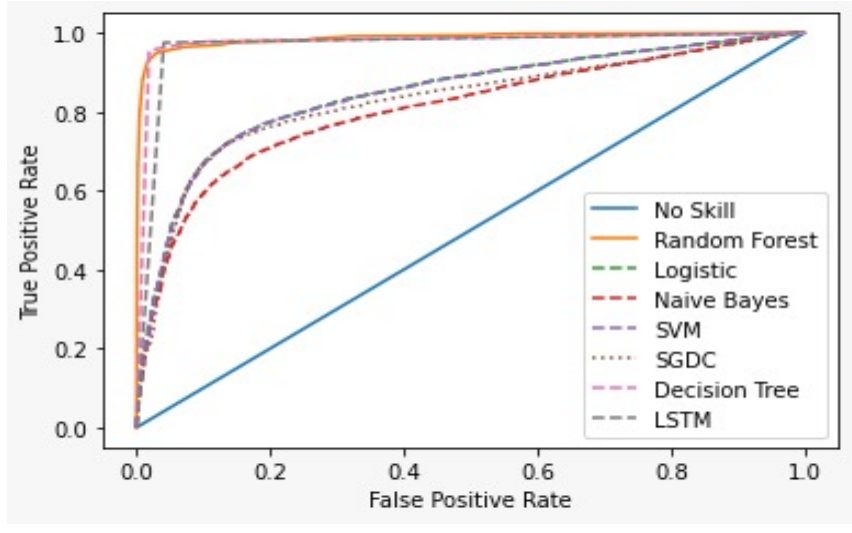
Figure 15. ROC curve for First dataset.